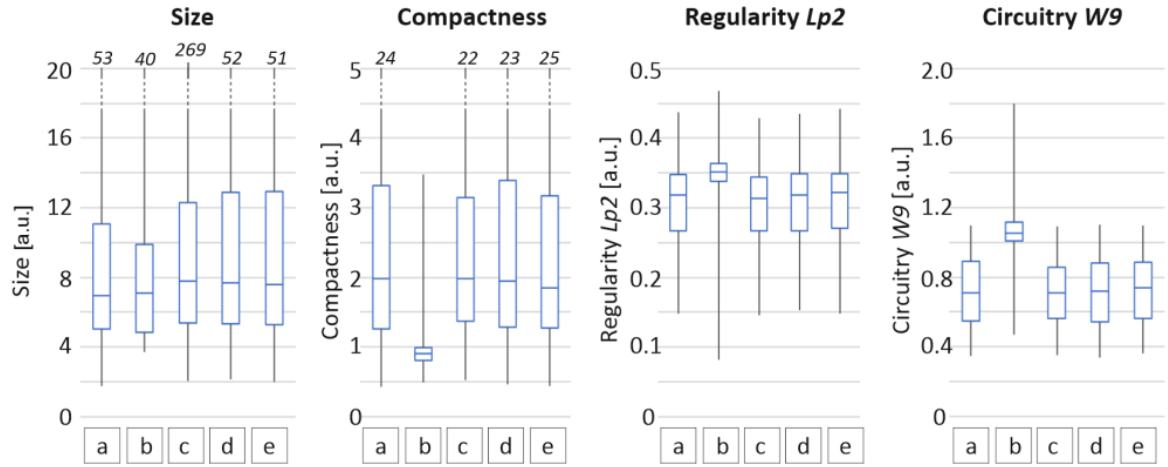
Figure 4. Coefficients of size, compactness, regularity and circuitry for Egyptian blue powders obtained after different dispersion operations: (a) reference powder, (b) 15 days of exfoliation (I), (c) horizontal bead mill (II), (d) three-roll mill (III) with medium M1, (e) three-roll mill (III) with medium M2.